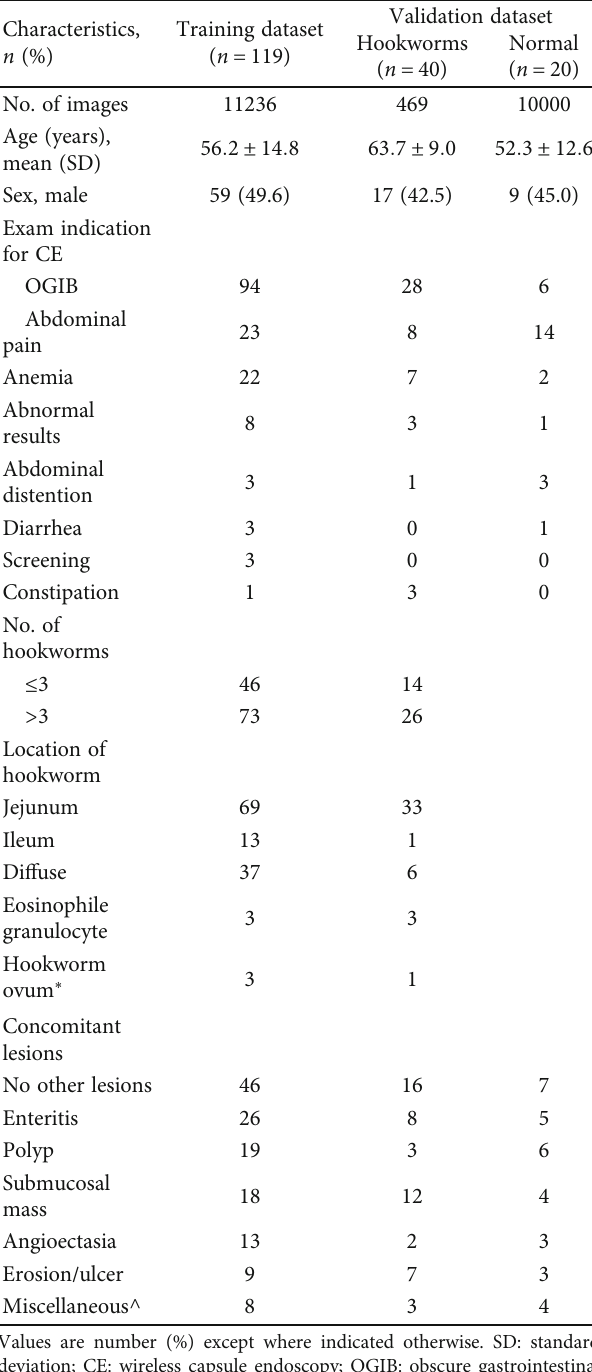
Table 1: Characteristics of patients in the training and validation